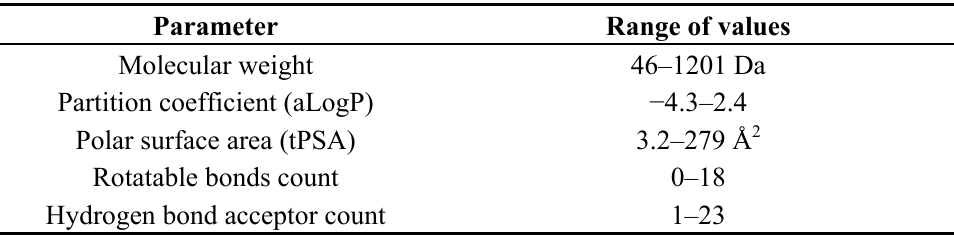
Table 1. Range of physico-chemical properties of the dataset (n = 120) used for classification